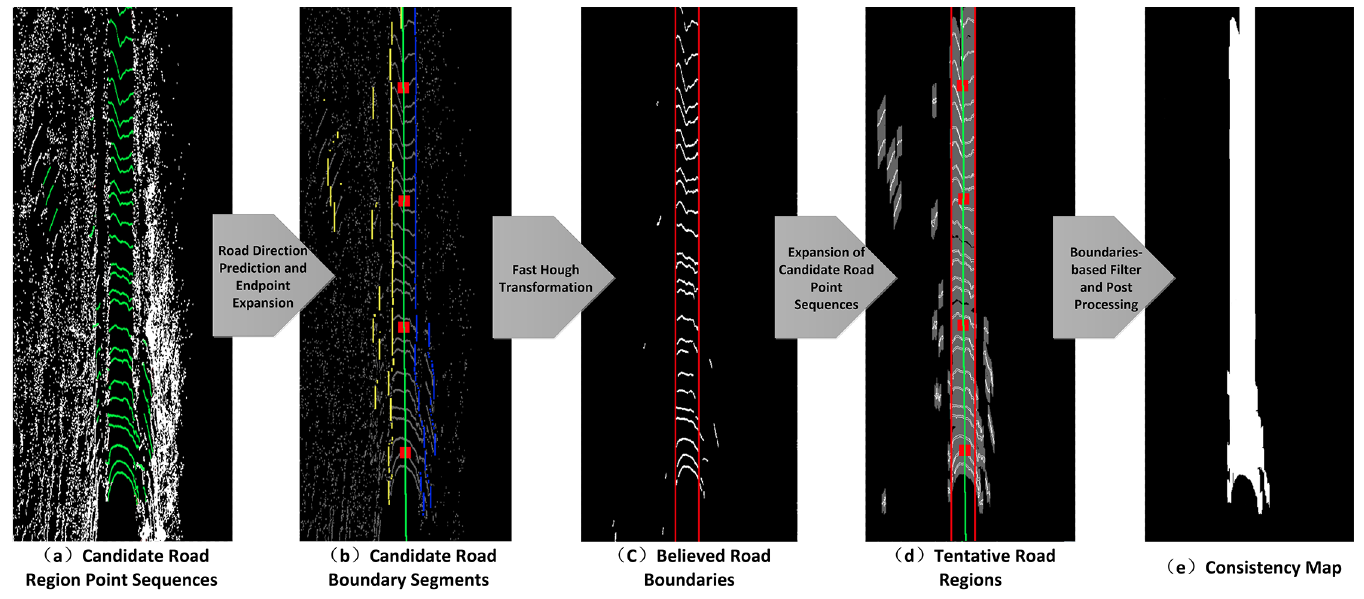
Fig 3. Consistency map M